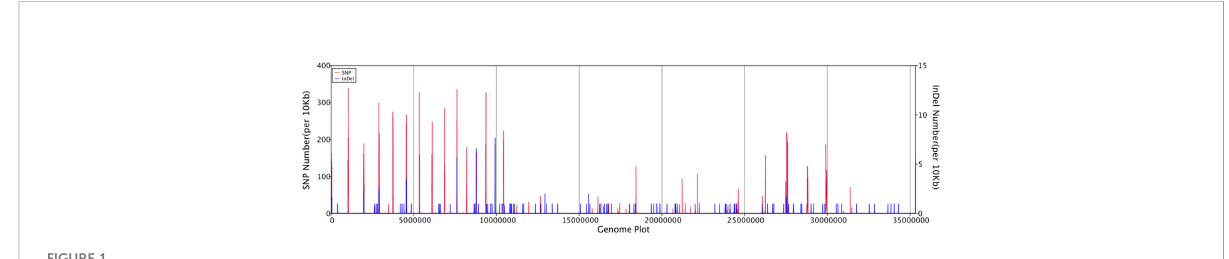
FIGURE 1 Distribution of SNPs and Indels along the genomes of isolates analyzed, with BMU 00512 taken as reference